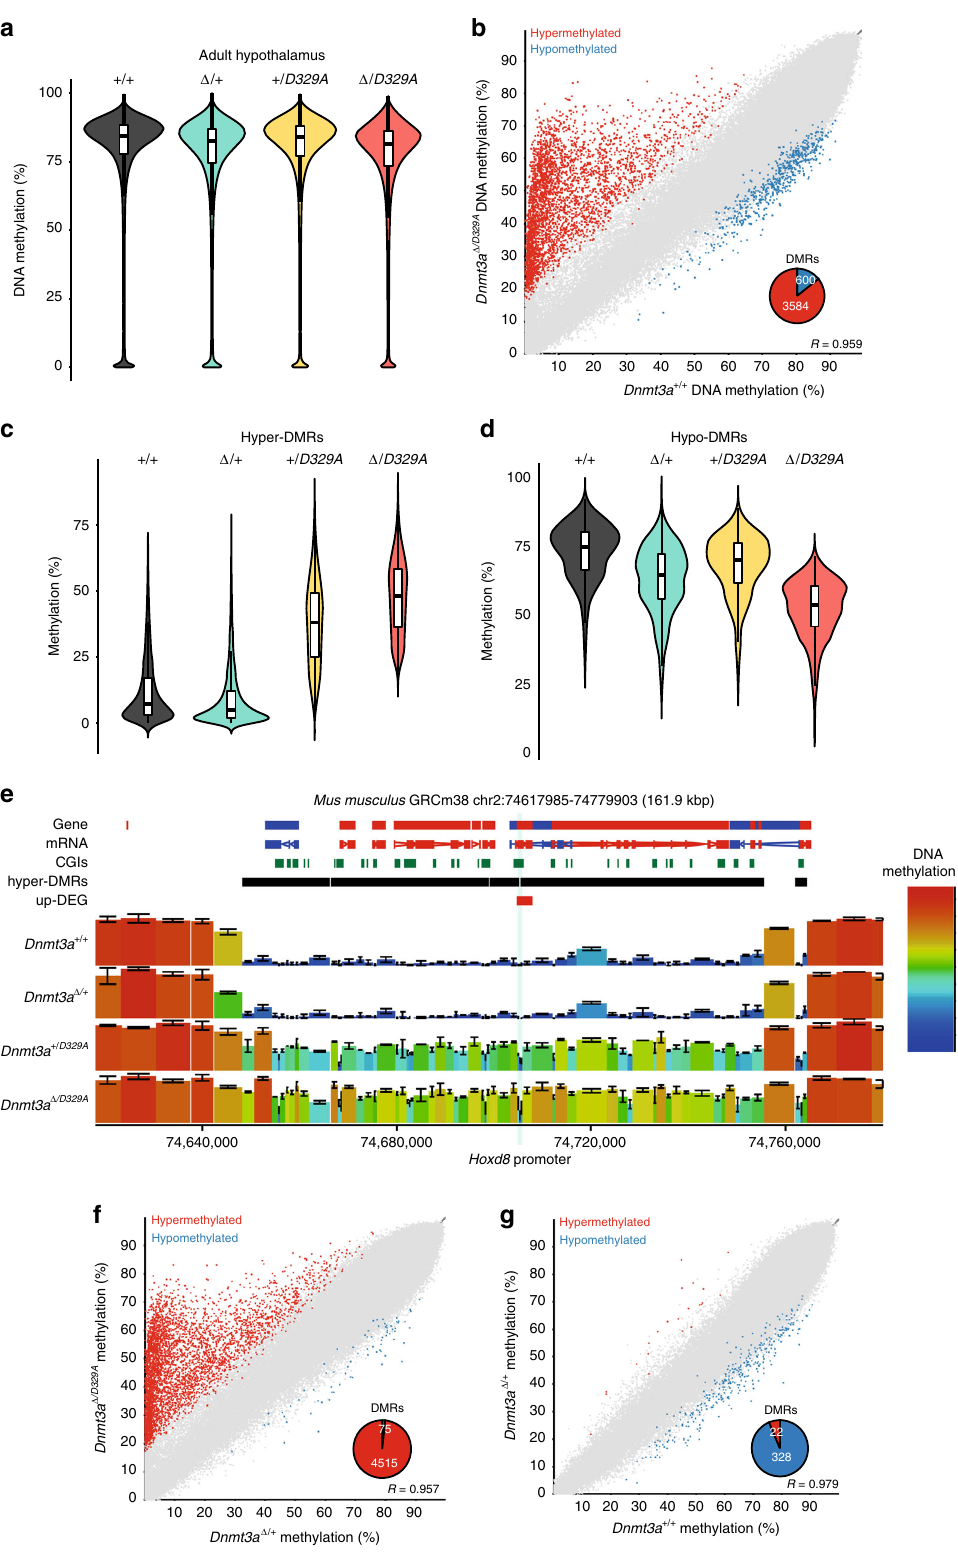
the major wave of post-implantation de novo methylation. In view of this result, and because hypothalamic neurons undergo further epigenetic modelling during postnatal maturation 51 ,